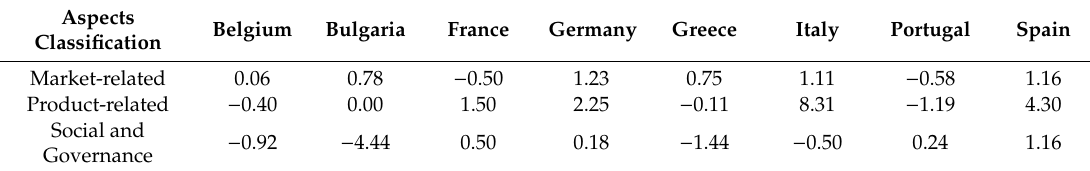
Table 4. Di ff erence positive minus negative aspects SWOT analysis.